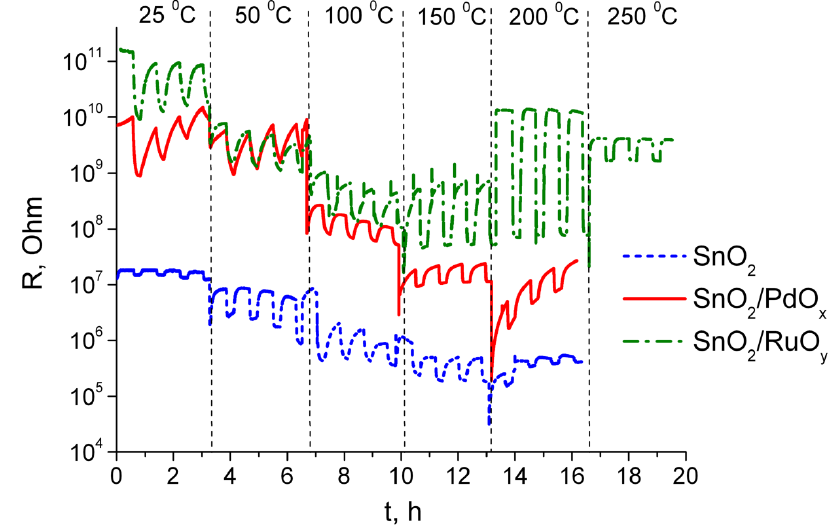
Figure 4. Dynamic resistance response of SnO 2 , SnO 2 /PdO x , and SnO 2 /RuO y sensors to the pulses of 50 ppm NH 3 in air at different